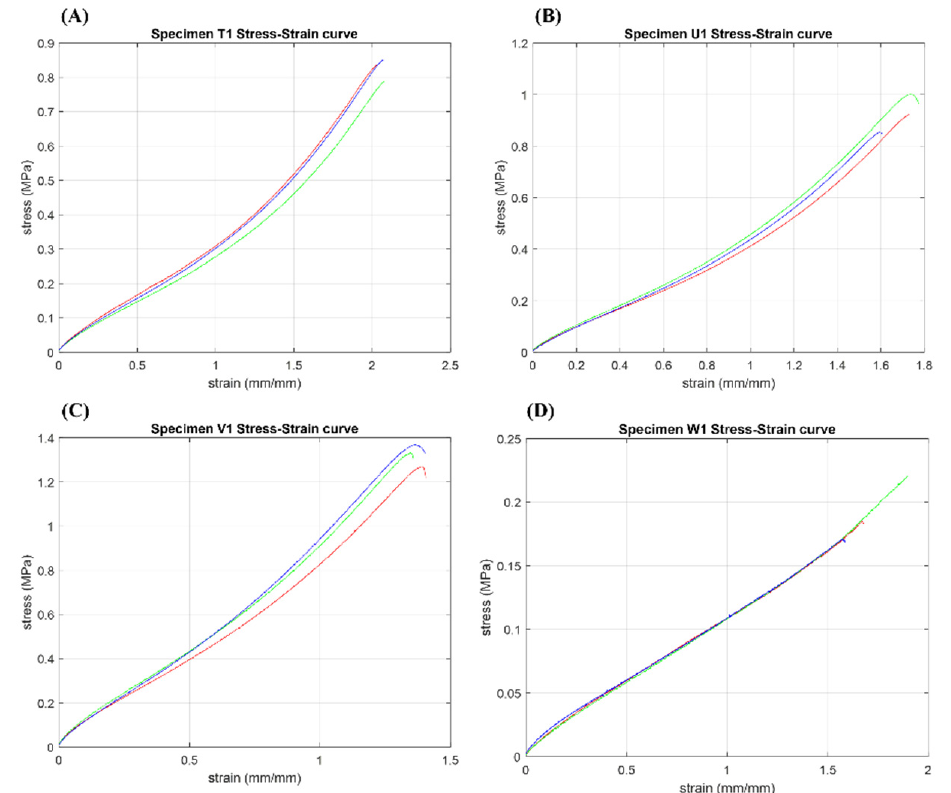
Figure 11. The stress–strain curves obtained after mechanical testing of base PolyJet materials. Specimens ID: ( A ) T1 = Agilus30™ base material-Shore hardness selected A50. ( B ) U1 = Agilus30™